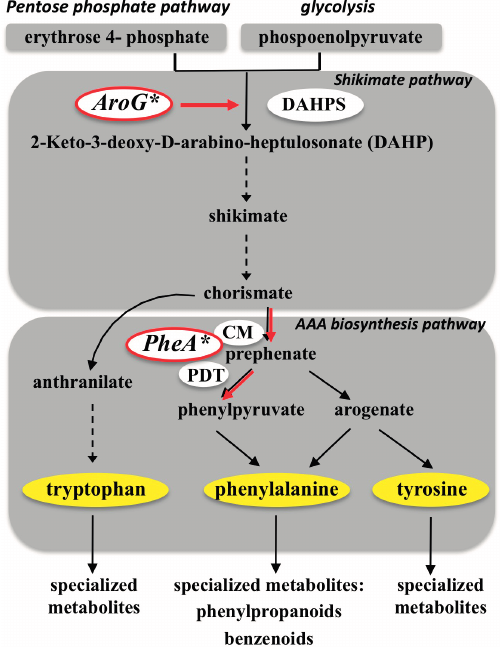
Figure 2. Schematic diagram of the shikimate and aromatic amino acid biosynthetic pathways in plants. Only some of the enzymes are depicted. Dashed black arrows represent several enzymatic steps. Red arrows represent enzymatic steps carried by the heterologously expressed bacterial enzymes AroG* and PheA*. DAHPS, 3-deoxy-d-arabino-2-heptulosonate 7-phosphate synthase; CM, chorismate mutase; PDT, prephenate